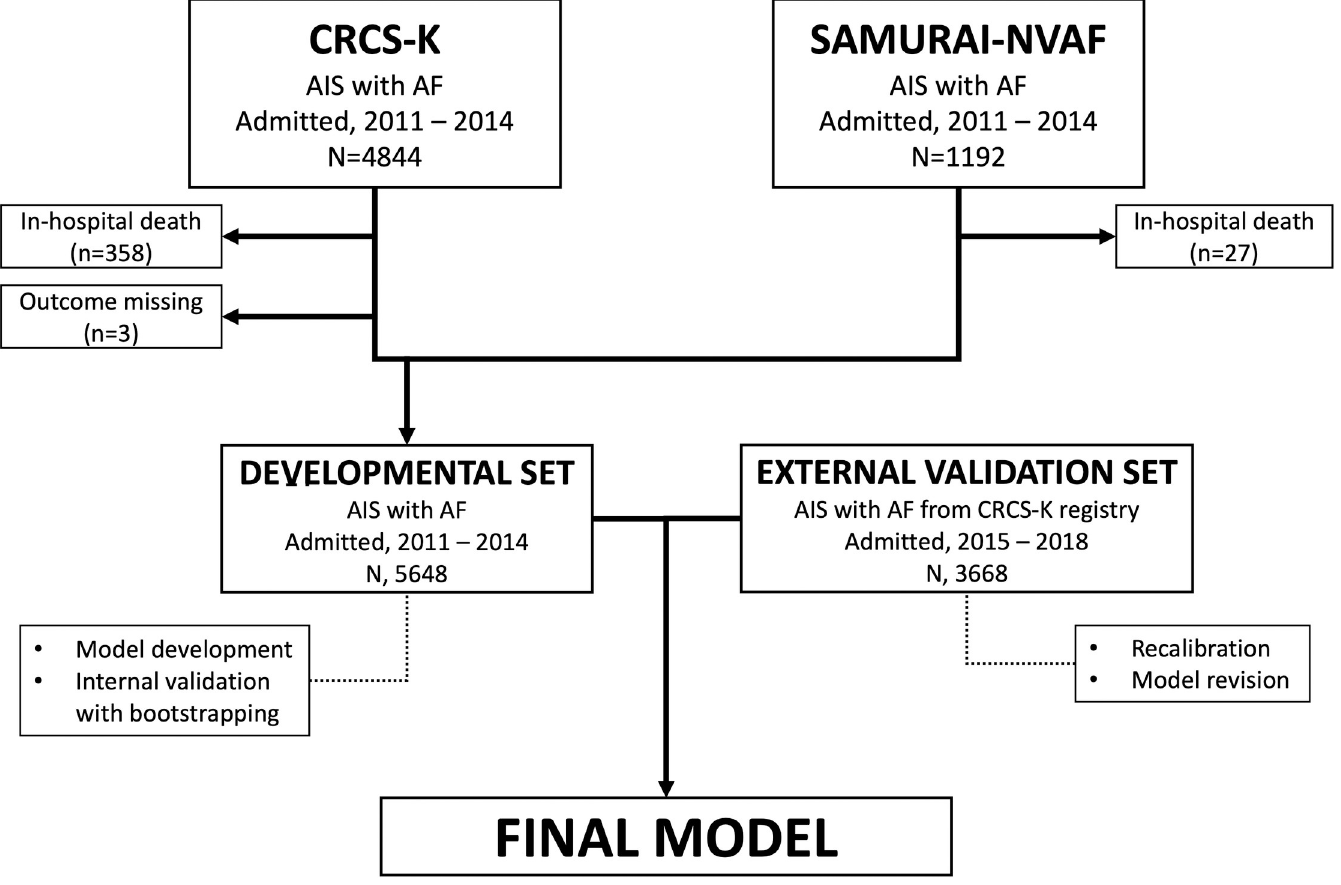
Fig 1. Overview of the study